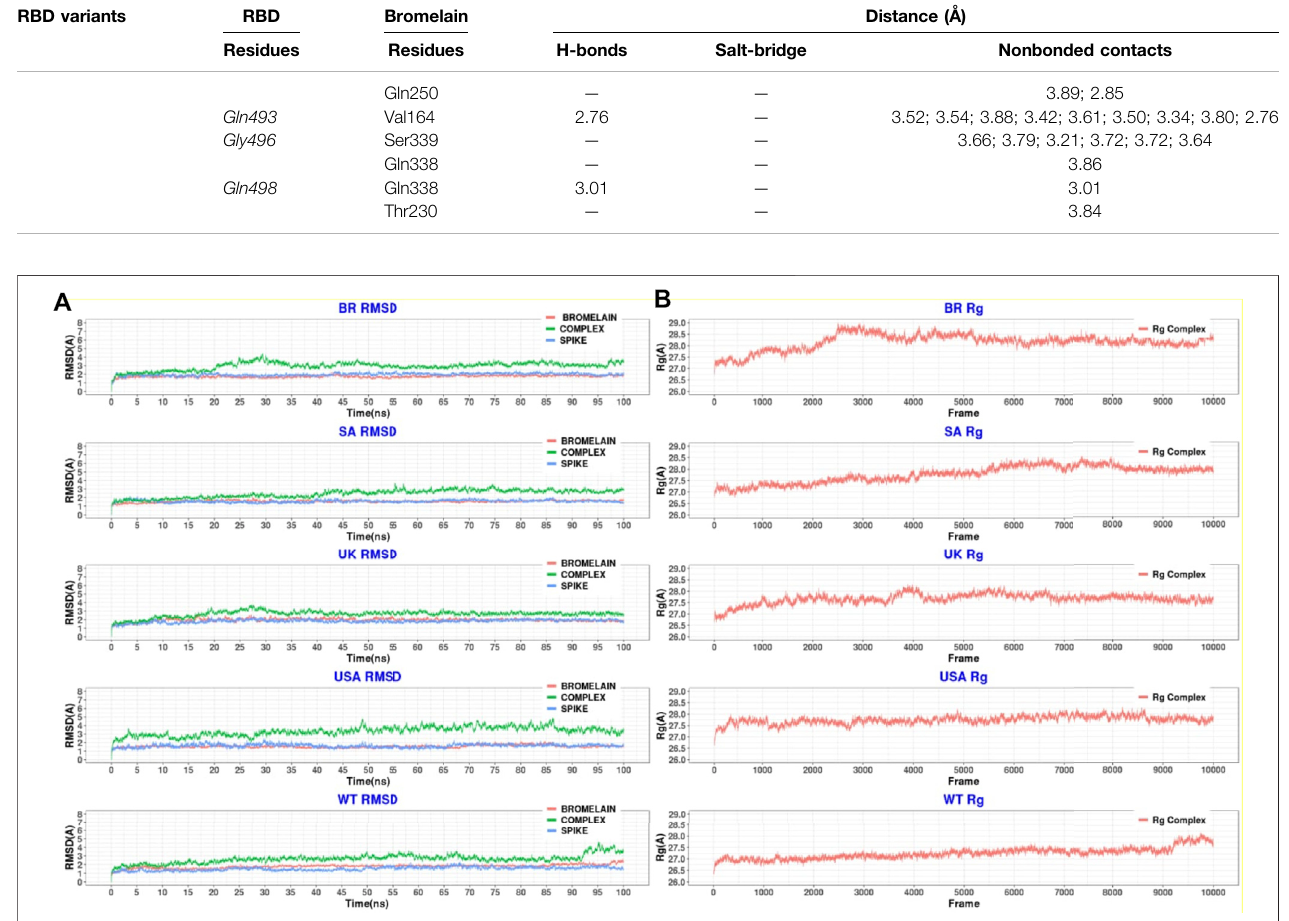
FIGURE 10 | A molecular dynamics simulation. (A) Root mean square deviation of bromelain, RBDs, and the complex of bromelain and RBDs, and (B) Radius of gyration of the complex of bromelain and RBDs.